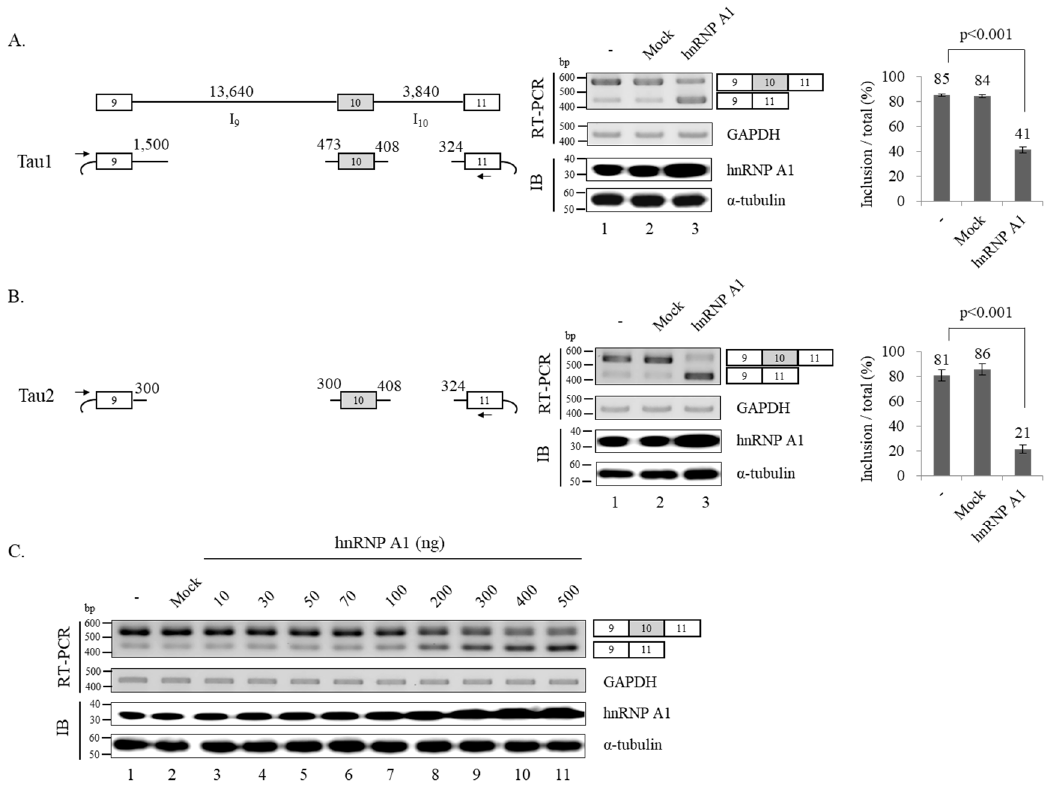
Figure 2. hnRNP A1 promotes alternative exon 10 skipping of Tau pre-mRNA. ( A ) (Left) Schematic of Tau1 minigene showing exons with boxes, introns with lines. Vector sequences are shown with arc. The primers used in RT-PCR analysis are shown with arrows. The length of deleted and remained intron are shown. (Middle) RT-PCR monitoring relative exon 10 skipped isoforms within Tau1 minigene in hnRNP A1 or control pcDNA (3.1) expressed cells. Immunoblotting analysis with anti-hnRNP A1 and α -tubulin are shown. (Right) Bar chart of RT-PCR of Tau1 is shown. ( B ) (Left) Schematic of Tau2 minigene with the length of remained intron 9 and 10. Primers for RT-PCR are shown with arrows. (Middle) RT-PCR analysis of relative exon 10 skipped isoforms within Tau2 minigene in hnRNP A1 or control pcDNA (3.1) expressed cells. (Right) Bar chart of RT-PCR of Tau2 splicing is shown. ( C ) RT-PCR monitoring of alternative splicing of exon 10 in cells transfected with different concentration hnRNP A1. The hnRNP A1 concentrations are shown on the top of lanes. GAPDH is used as a loading control.